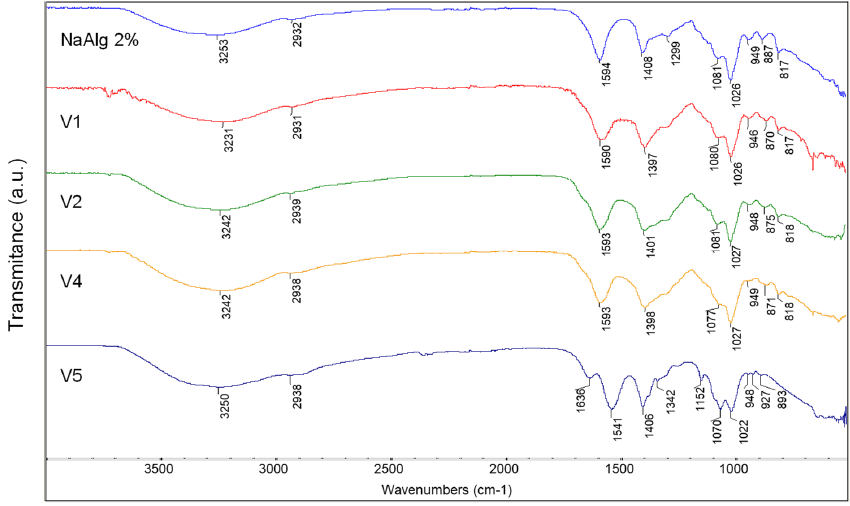
Figure 1. The FT ‐ IR spectra of NaAlg 2%, V1, V2, V4, and V5 amorphous hydrogels